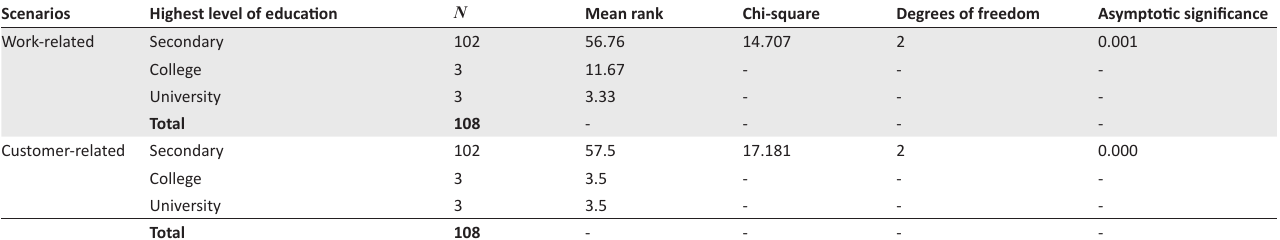
TABLE 5: Results of the Kruskal–Wallis rank sum test with highest level of education as the grouping variable. Scenarios